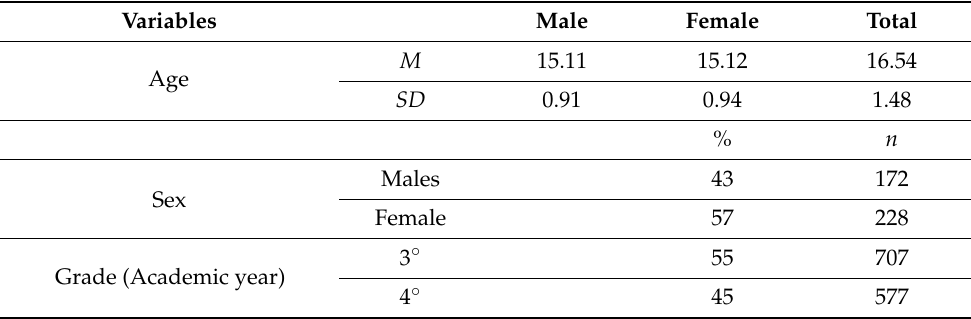
Table 1. Sociodemographic characteristics of the sample.